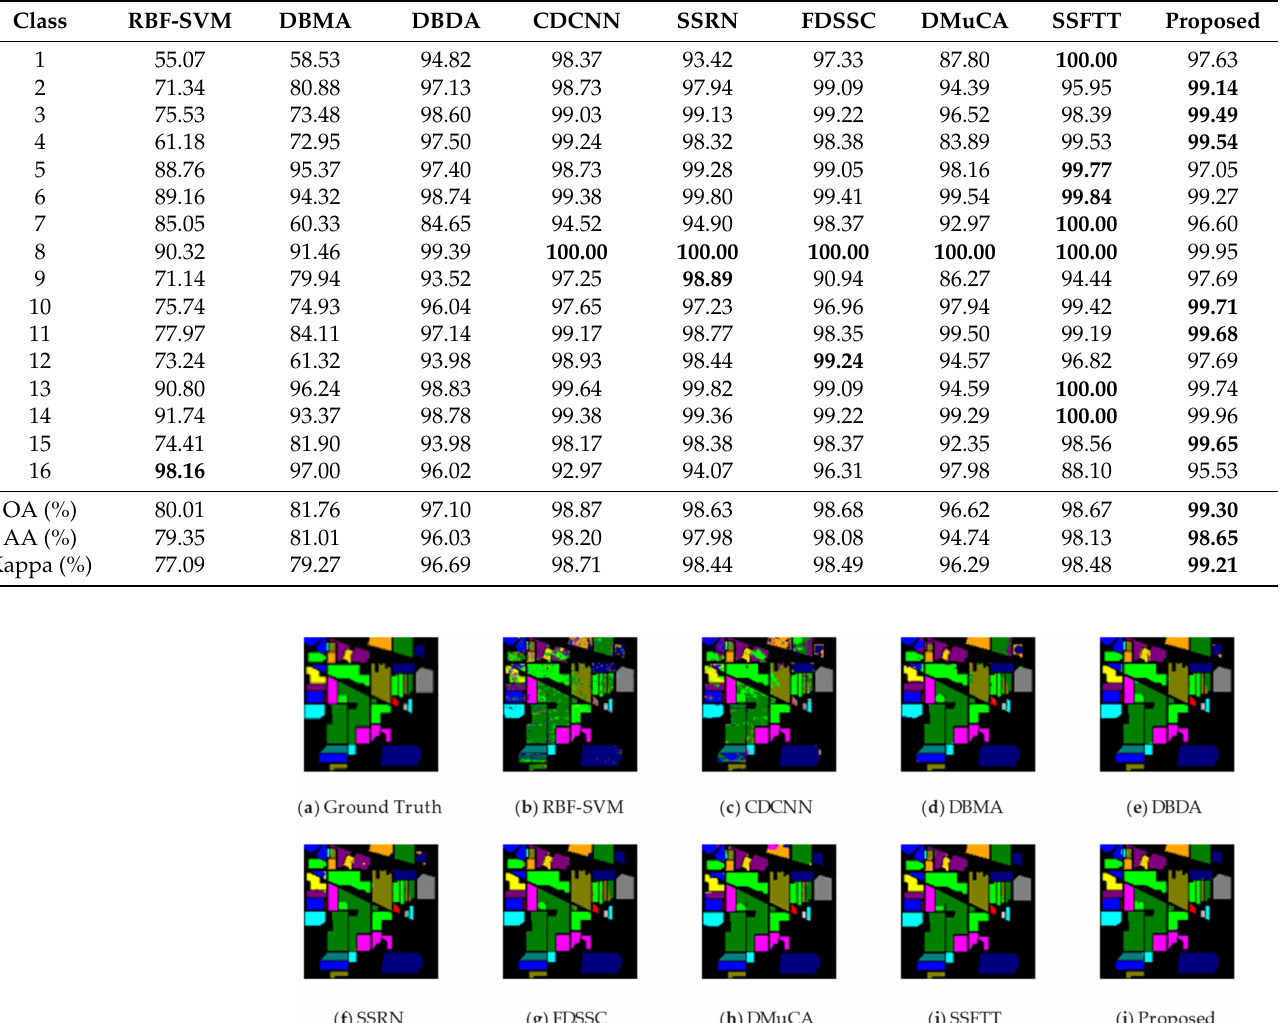
Figure 12. Classification maps of the Indian Pines dataset with 10% training